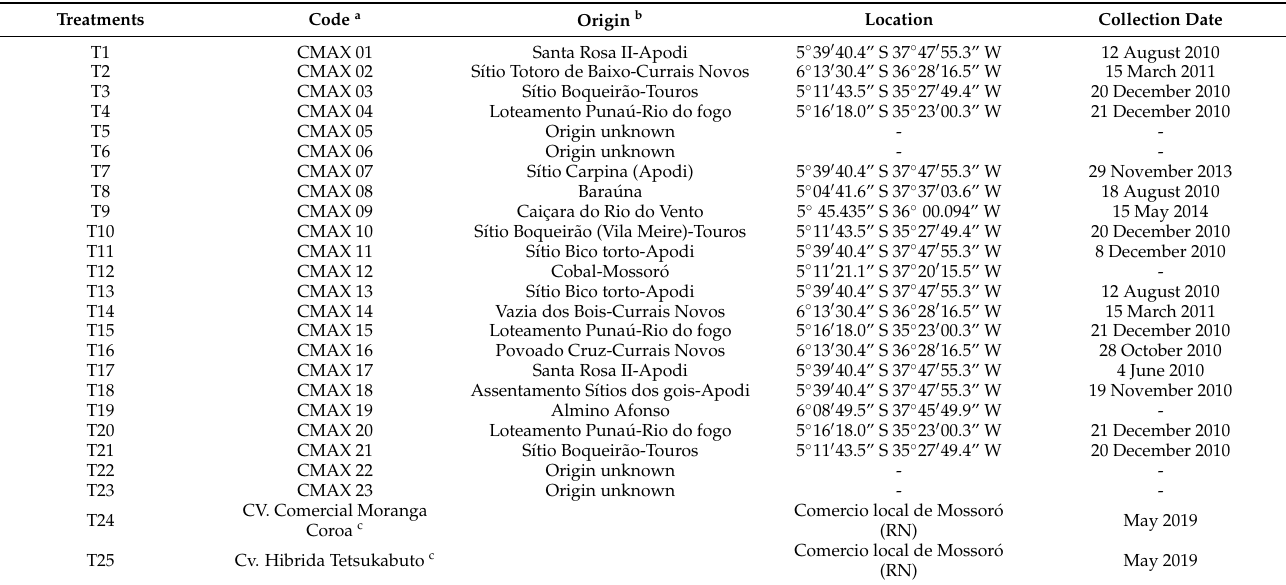
Table 1. Origin and location of Cucurbita maxima germplasm evaluated for total carotenoid and β -carotene